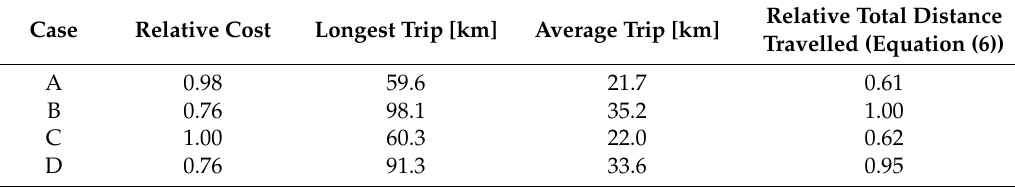
Table 7. Lines topology—a summary of the obtained results.